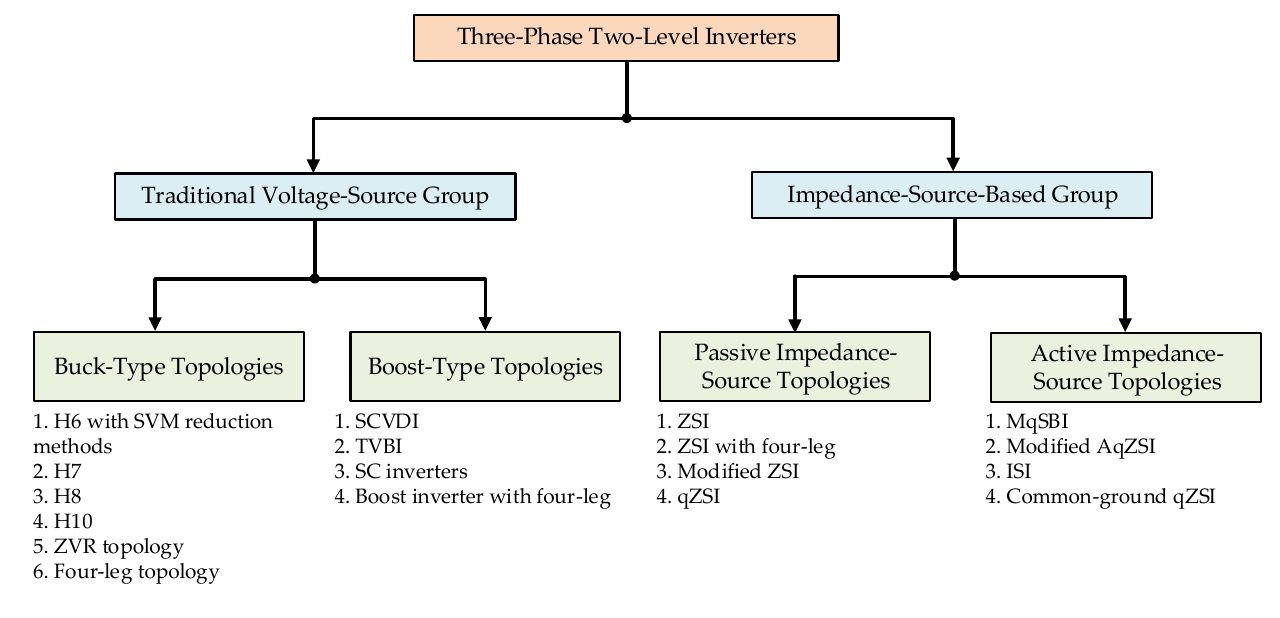
Figure 3. Classification of three-phase, two-level inverter topologies.